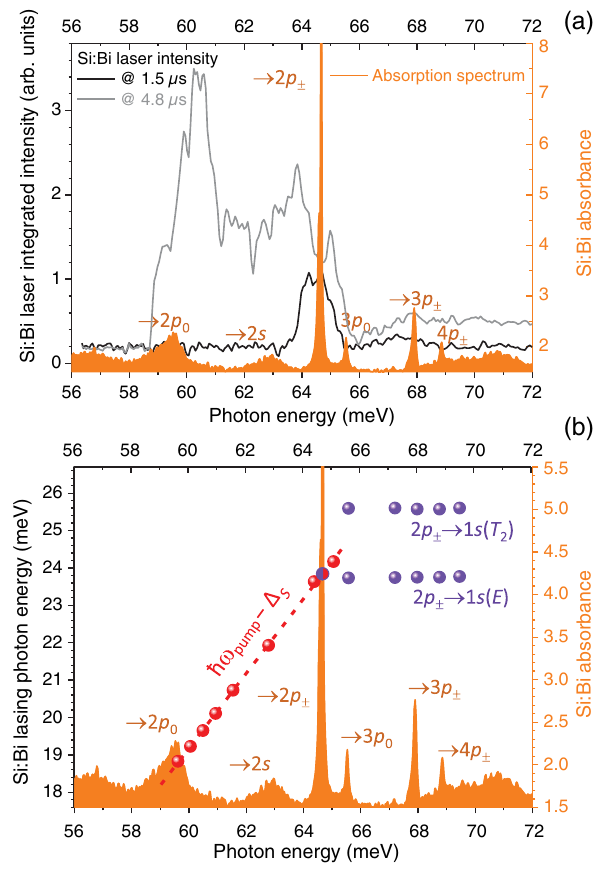
FIG. 3. (a) Integrated intensity of the Si ∶ Bi laser vs FEL pump photon energy at different times elapsed from the front of the pump pulse and compared with the Si ∶ Bi absorption spectrum. Note that the Si ∶ Bi lasing starts on the 1 s ð A 1 Þ → 2 p transition (cid:2) where pumping is most effective for the PIL transition 1 s ð A 1 Þ → 2 p (at about 64 . 6 meV, 19 . 2 μ m). With a delay of a few (cid:2) microseconds the SRS-typical, broad lasing spectrum sets on and dominates towards the end of the pump macropulse (see also complementary file Si_Integrated_Emission.gif for full recon- structed dynamics [18]). The spectral resolution of pump spectra is 0 . 05 μ m and of absorption spectrum is 0 . 1 cm − 1 . (b) Depend- ence of the photon energy and intensity of the SRS and PIL emission on the pump photon energy. The Si ∶ Bi absorption spectrum is given for orientation. The circles show the pump photon energies where Si ∶ Bi emission spectar were taken. Note the linearity of the SRS lasing frequency with the pump photon energy and the Stokes shift of about 40.8 meV. The SRS lasing (dashed line) spans the pump photon range from below the 2 p 0 excited state up to the 3 p 0 excited state. Pumping in the 2 p Bi (cid:2) state results in joint PIL and SRS lasing. Pumping in the 3 p 0 Bi state and above results in PIL